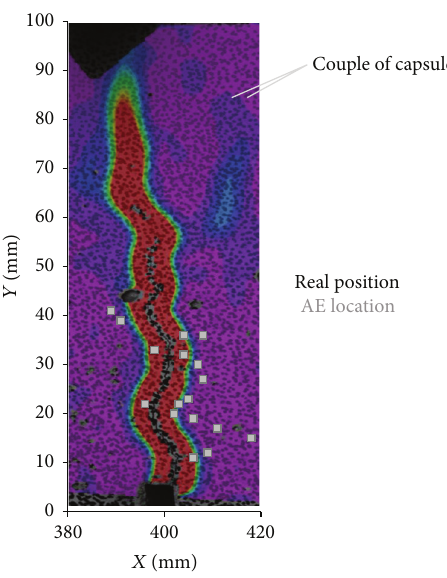
Figure 13: AE capsule location across the length of the beam and crack opening DIC fracture